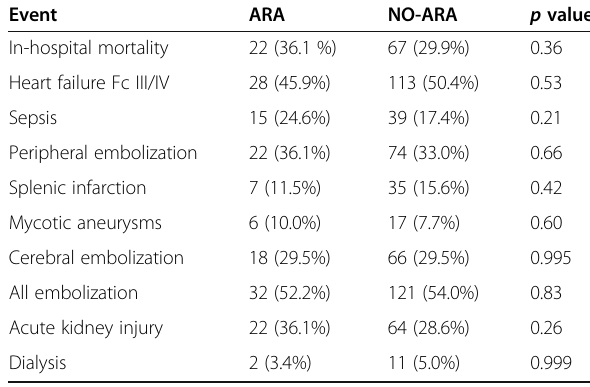
Table 3 Major complications in ARA and NO-ARA groups, N